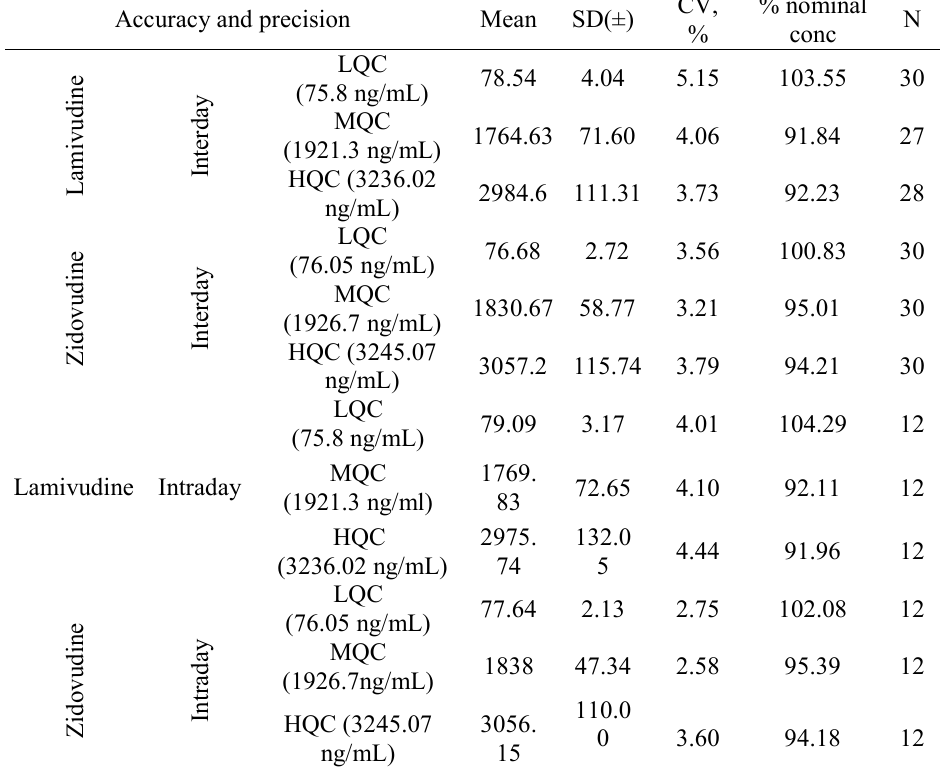
Table 3. Inter day and intra day precision and accuracy for LAM and ZID. Accuracy and precision